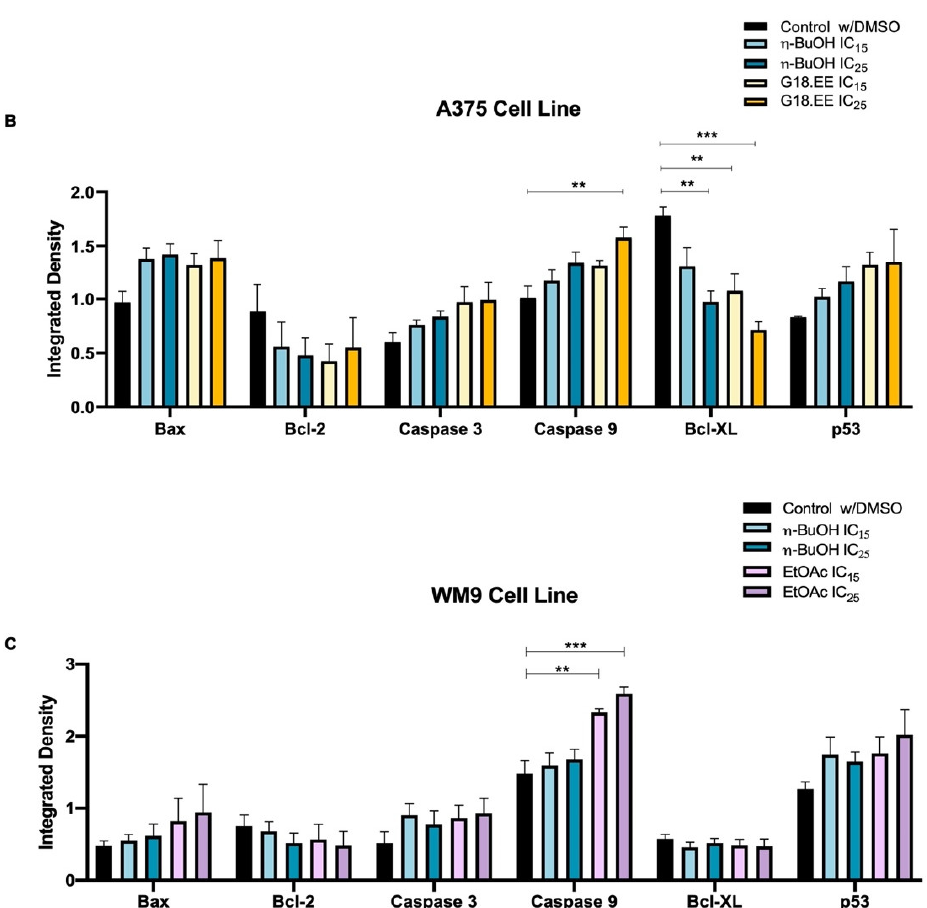
Figure 4. Pro-apoptotic mechanisms are activated by G18.EE, n -BuOH, and EtOAc in melanoma cells. Apoptotic markers were evaluated in the different conditions by ( A ) Western blot and quantified in A375 ( B ) and WM9 ( C ) cell lines. A375 and WM9 cells treated with DMSO were used as controls. Except for phospho-p53, which was normalized for total p53, the remaining proteins were normalized to tubulin. Results are expressed as mean ± SD. Results are from three independent experiments carried out in triplicate. ** p < 0.01, *** p <